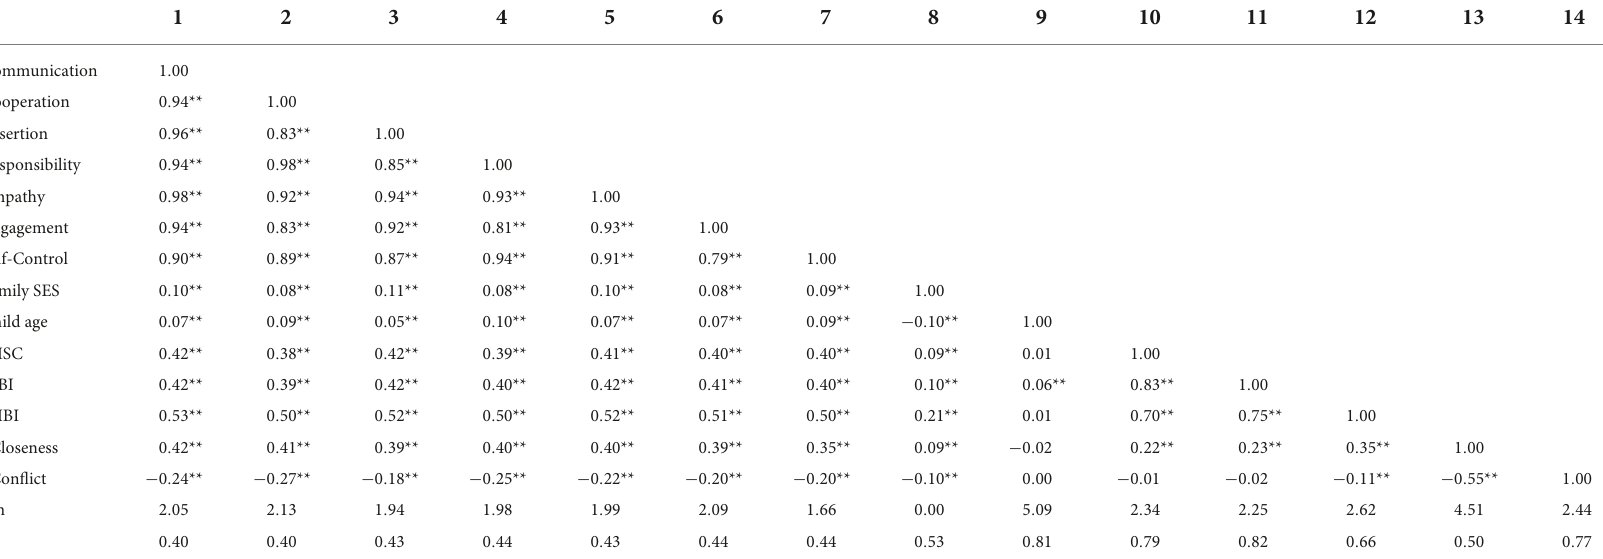
TABLE 2 Bivariate correlation, mean, and standard deviation of studied